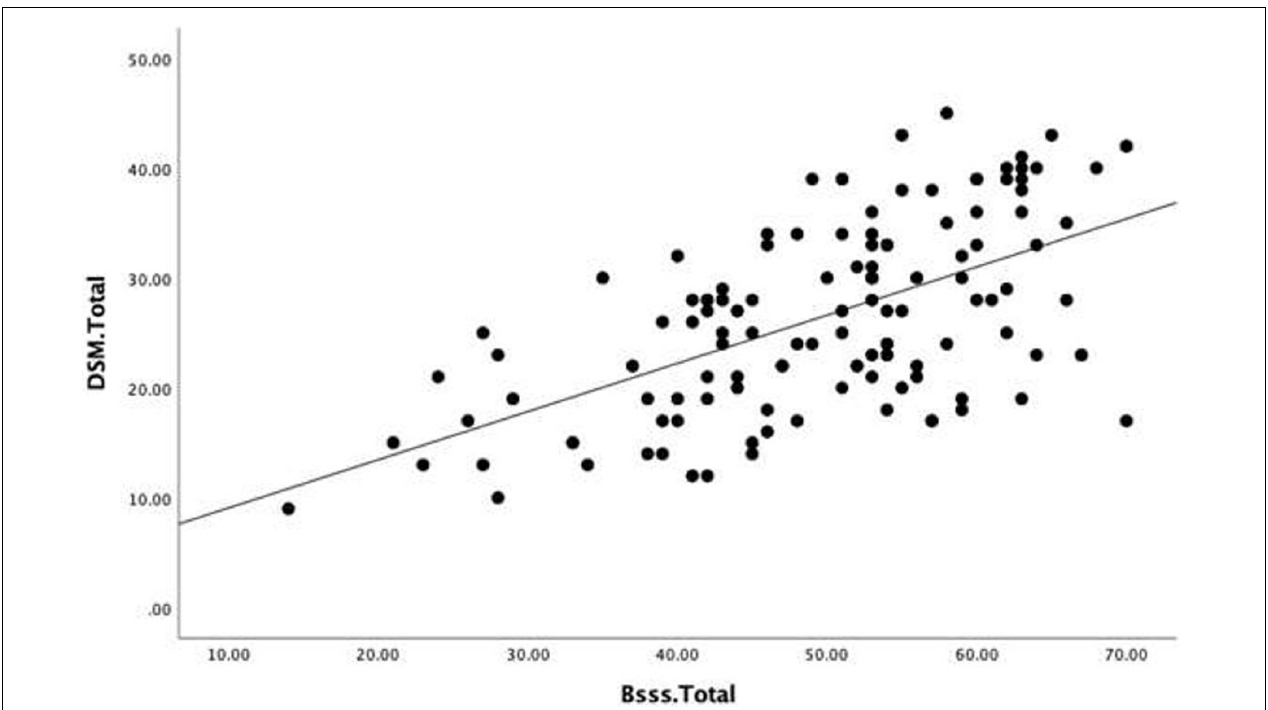
FIGURE 1 | Proportion of total BSS and DSM scores identified by participants ( n = 257).